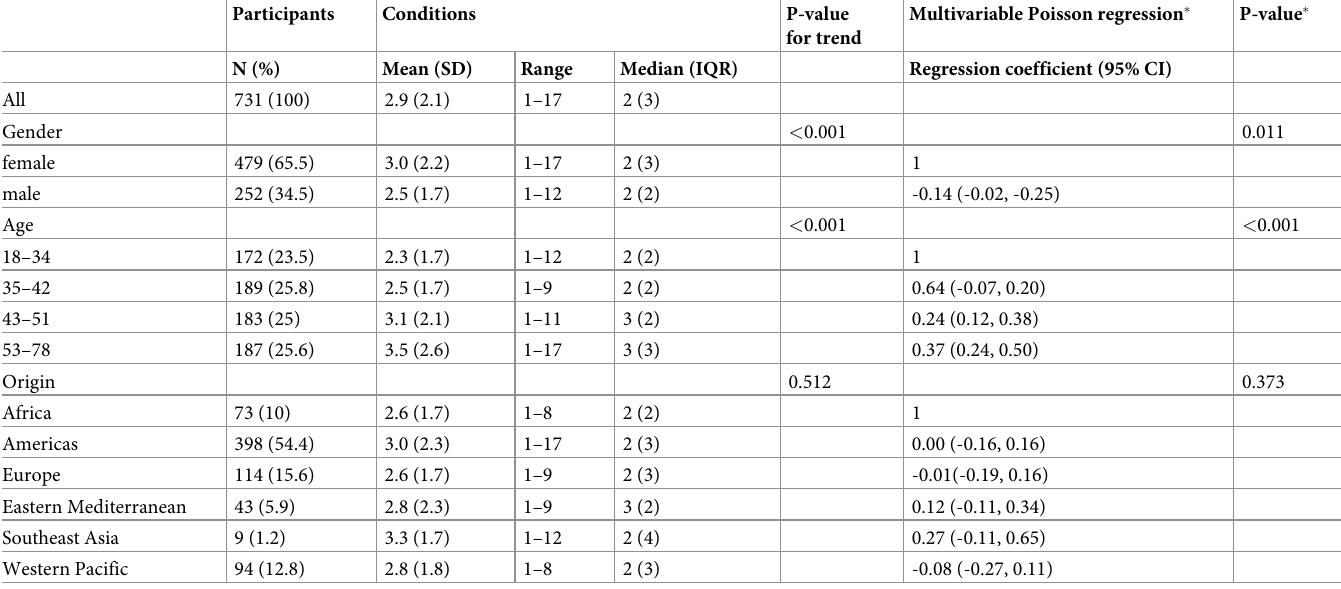
Table 1. Number of conditions among undocumented migrants (n =